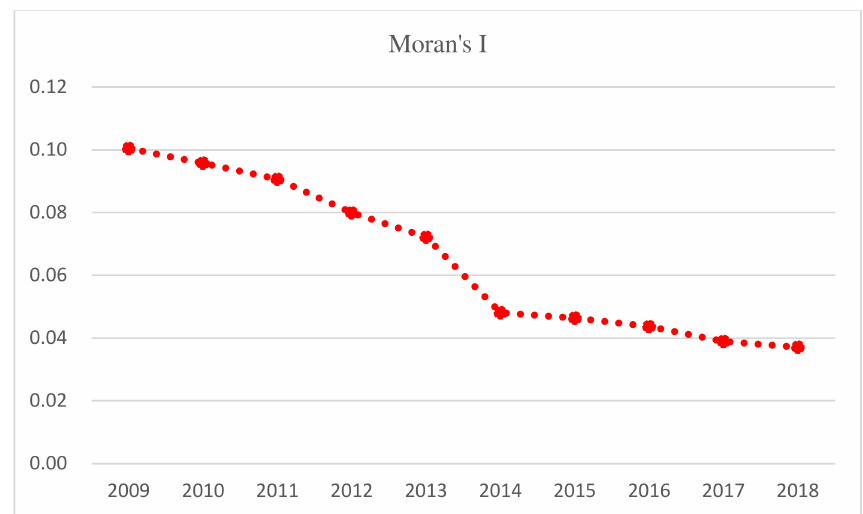
Figure 5. Moran’s I of HQD of seven urban agglomerations.